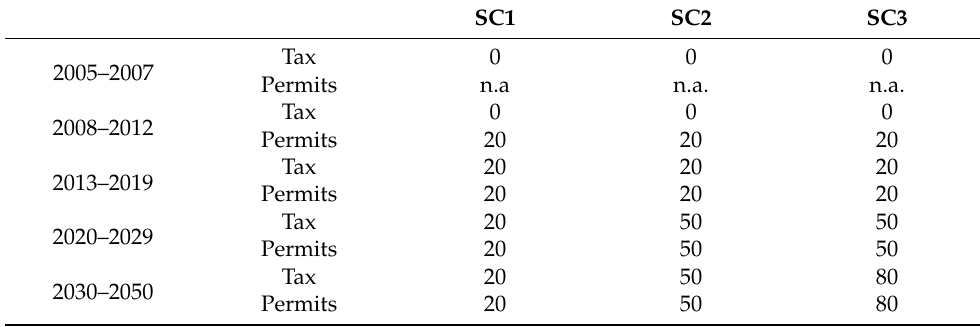
Table 8. Price evolution for taxes and permits ( €